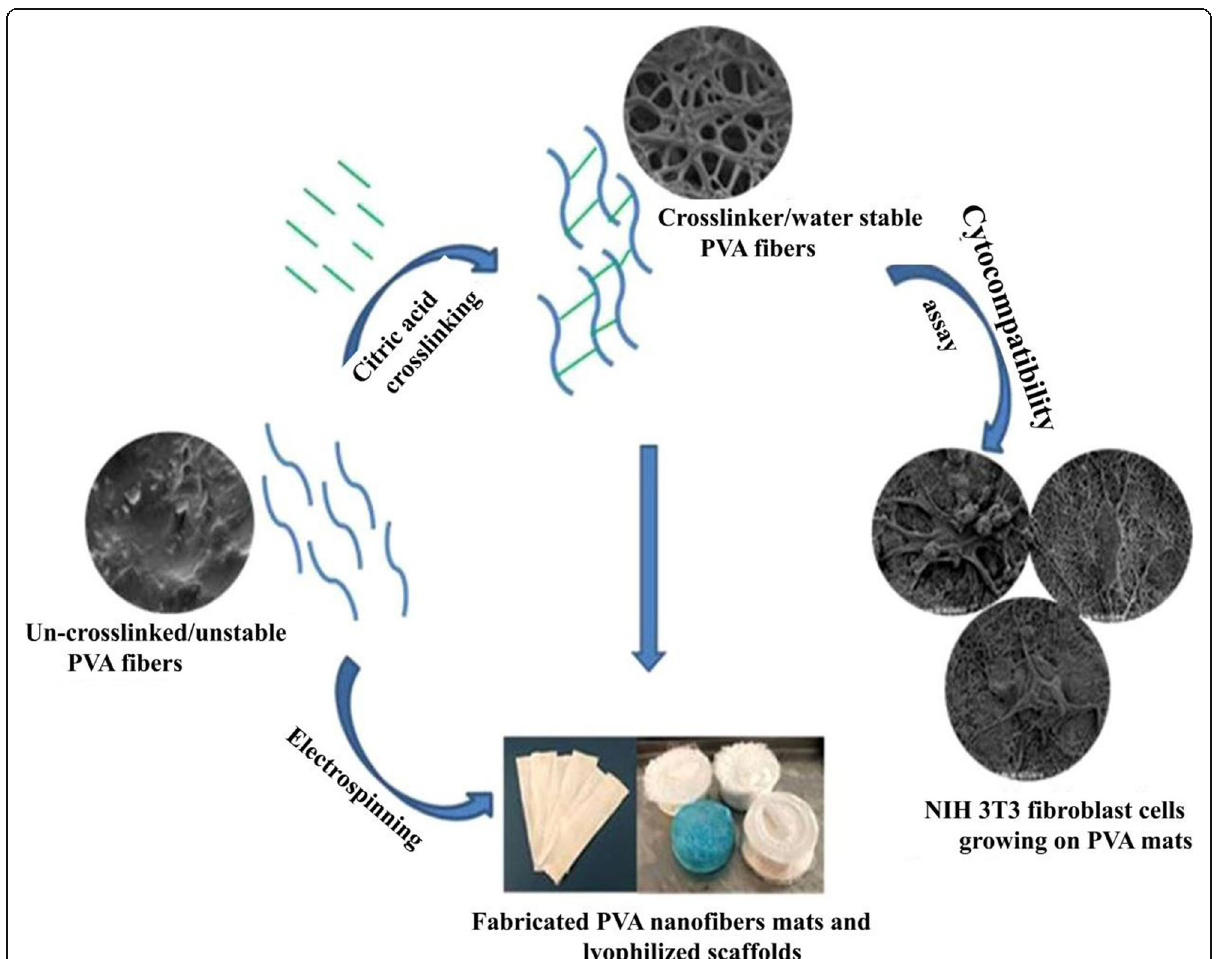
Fig. 4 Representation of stable crosslinking electrospun PVA nanofibers with CA for medical applications. [ “ Reprinted (adapted) with permission from [15] Copyright 2019 Elsevier. ”